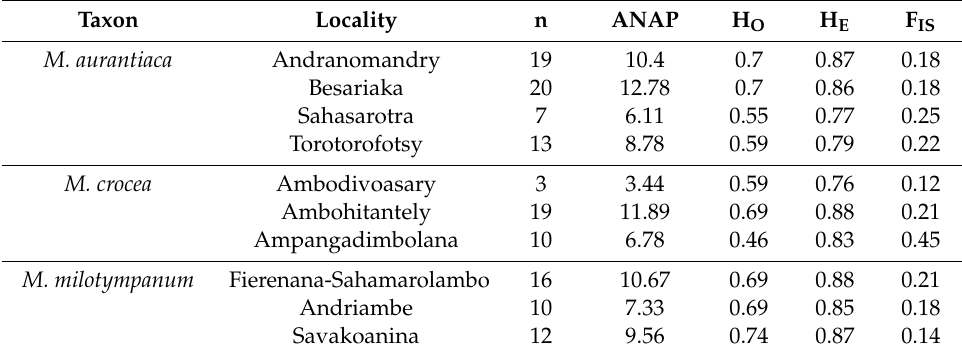
Table 1. Distribution of sample size per site and species for the population genetic analyses. n: sample size; ANAP: average number of alleles per locus; H O : observed heterozygosity; H E : expected heterozygosity; F IS : inbreeding coe ffi